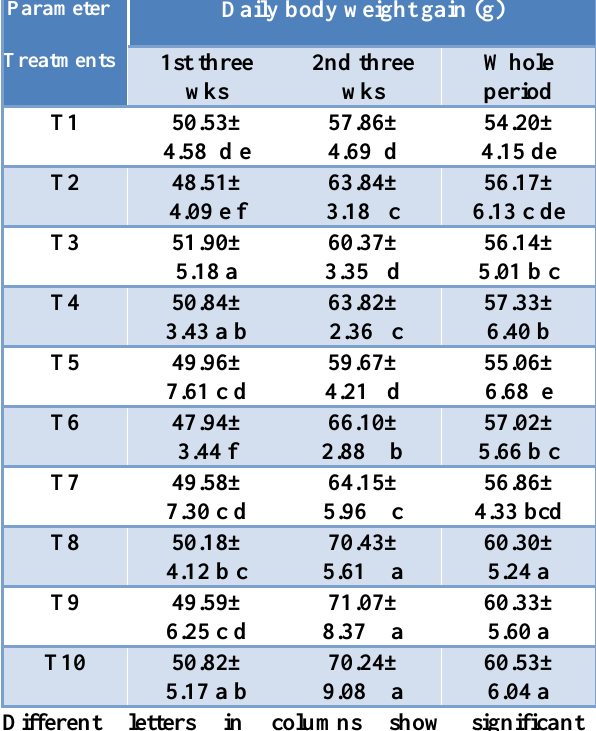
letters in columns show significant differences at level